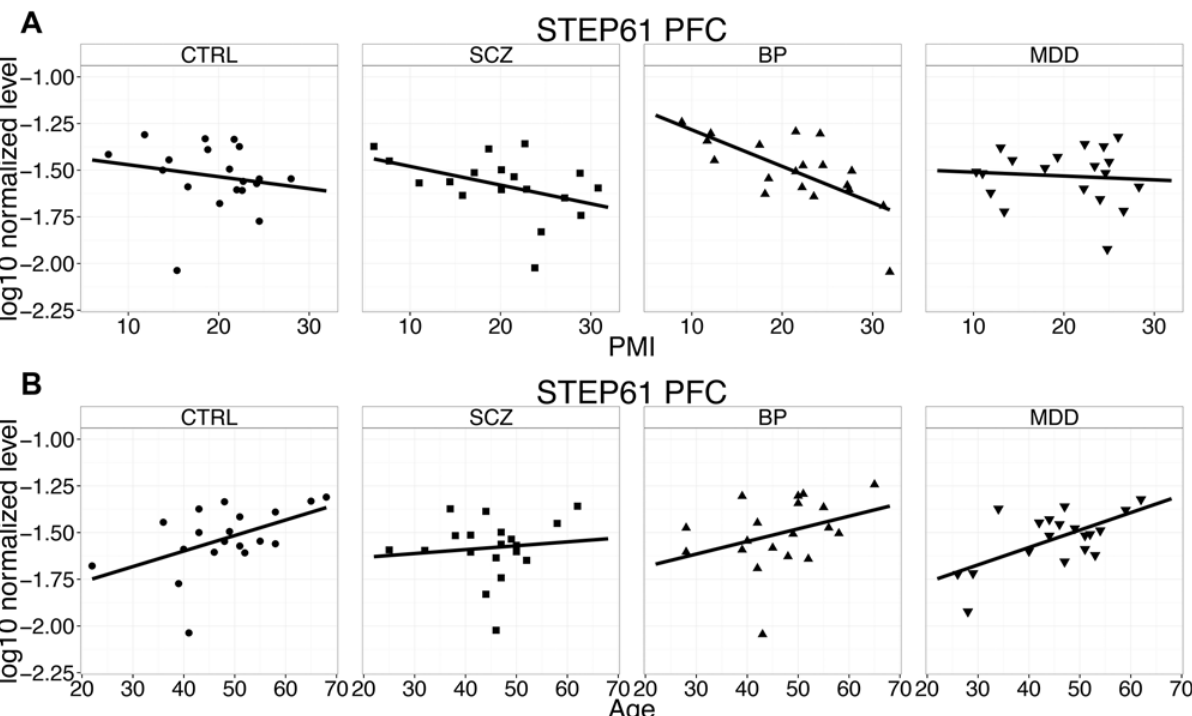
Fig 4. Postmortem samples showed dependence between postmortem interval PMI (A) and Age (B) and STEP protein levels analyzed by Western blot in PFC from bipolar (BP), control (CTRL), major depression (MDD) and schizophrenic (SCZ)